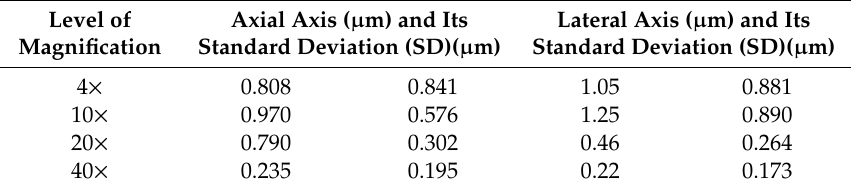
Table 1. The average variation between Image J software and vision